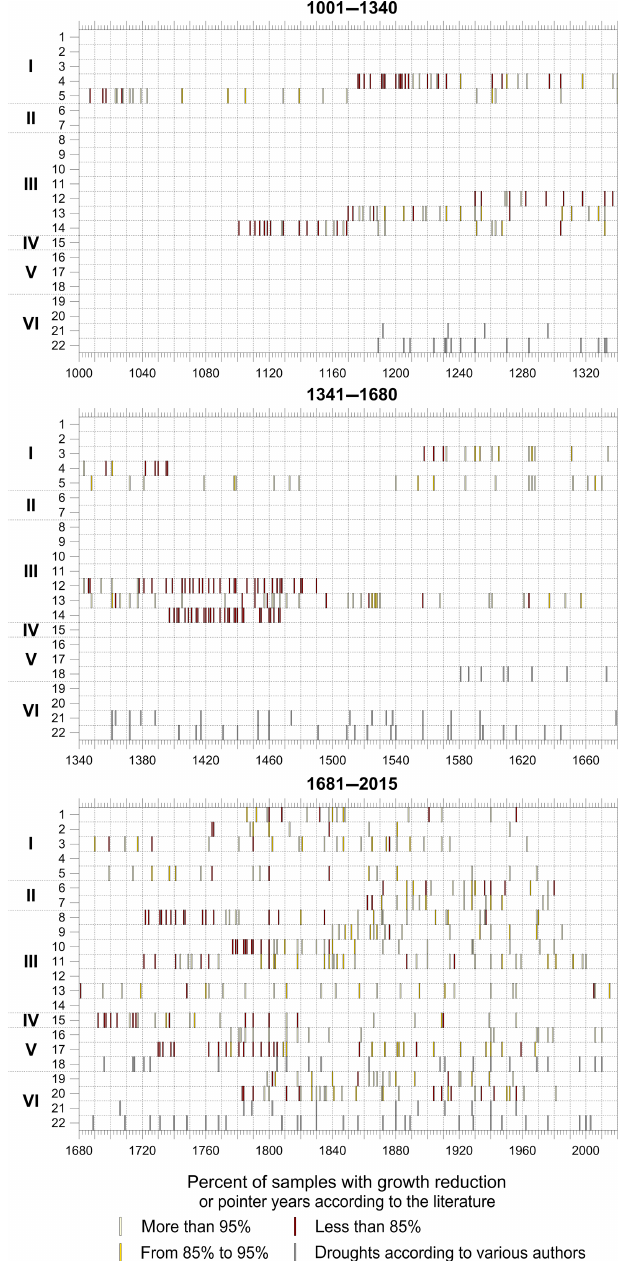
Figure 6. Pointer years in Poland (1001–2015).